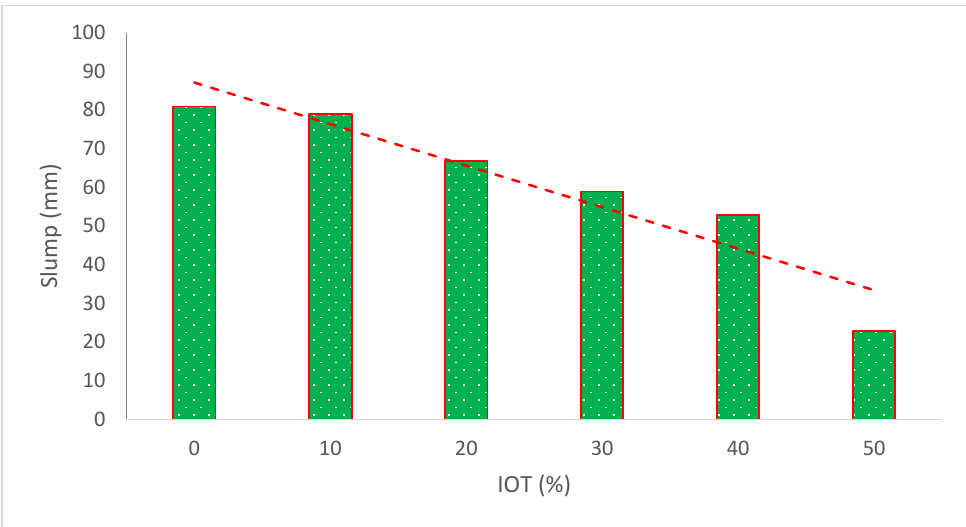
Figure 5. Slump flow results (data source